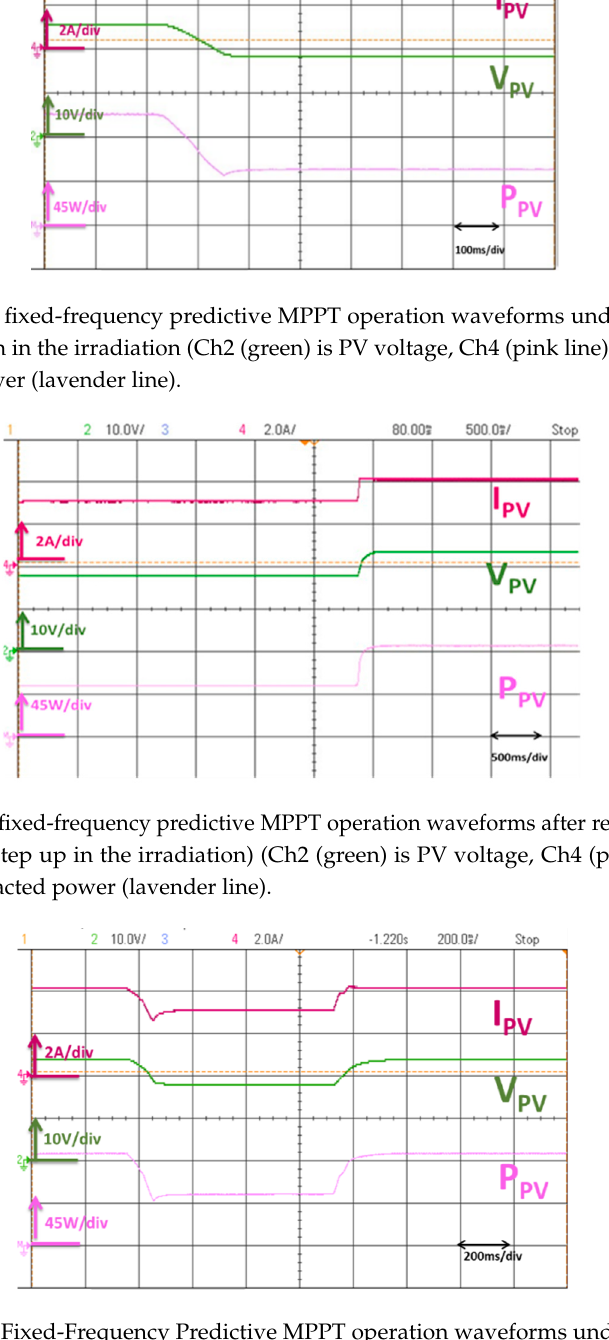
Figure 16. Proposed Fixed-Frequency Predictive MPPT operation waveforms under partial shading condition (two-step step down then step up in the irradiation) (Ch2 (green) is PV voltage, Ch4 (pink line) is the PV current), the PV extracted power (lavender line ).